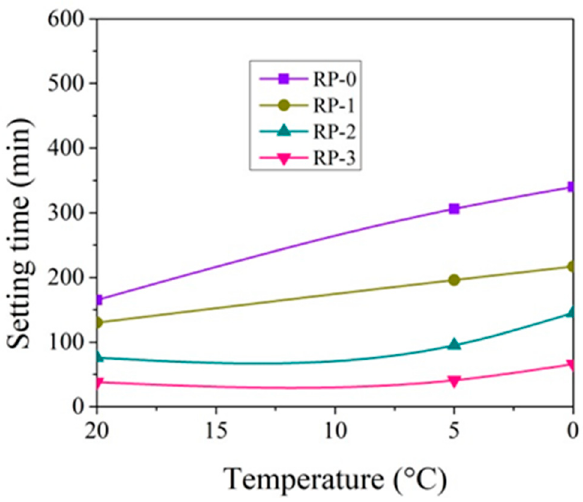
Figure 3. Initial setting times of CEM IIR paste with 0–3% CN at different temperatures.